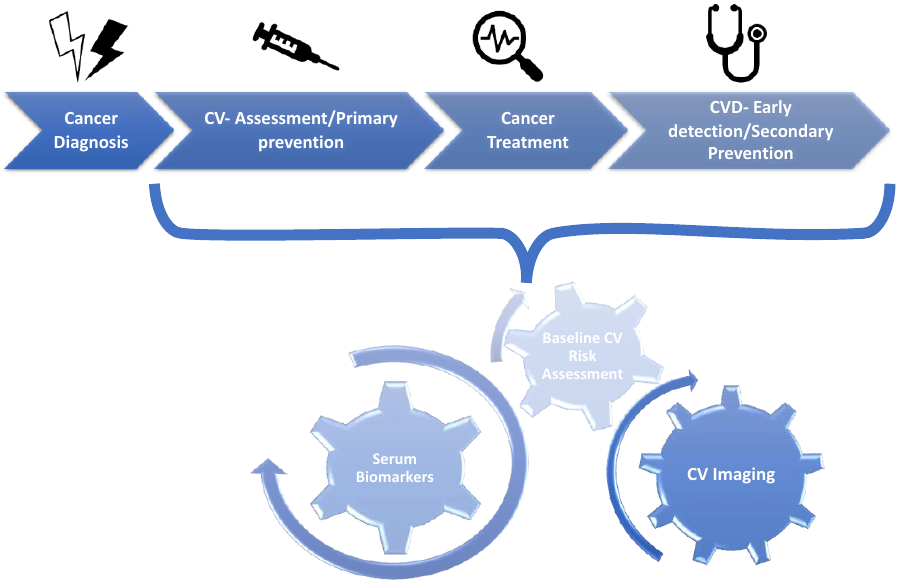
Figure 1. Cardio-oncology: an integrated approach throughout cancer disease [7]. Abbreviations: CV, cardiovascular, CVD, cardiovascular disease.